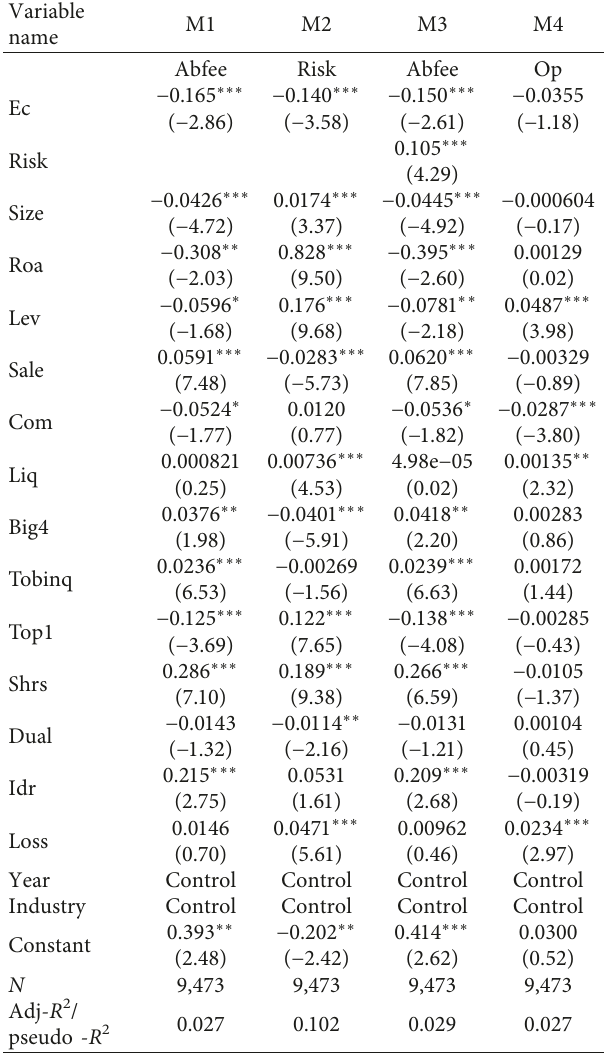
Table 8: The results of the mechanism test.